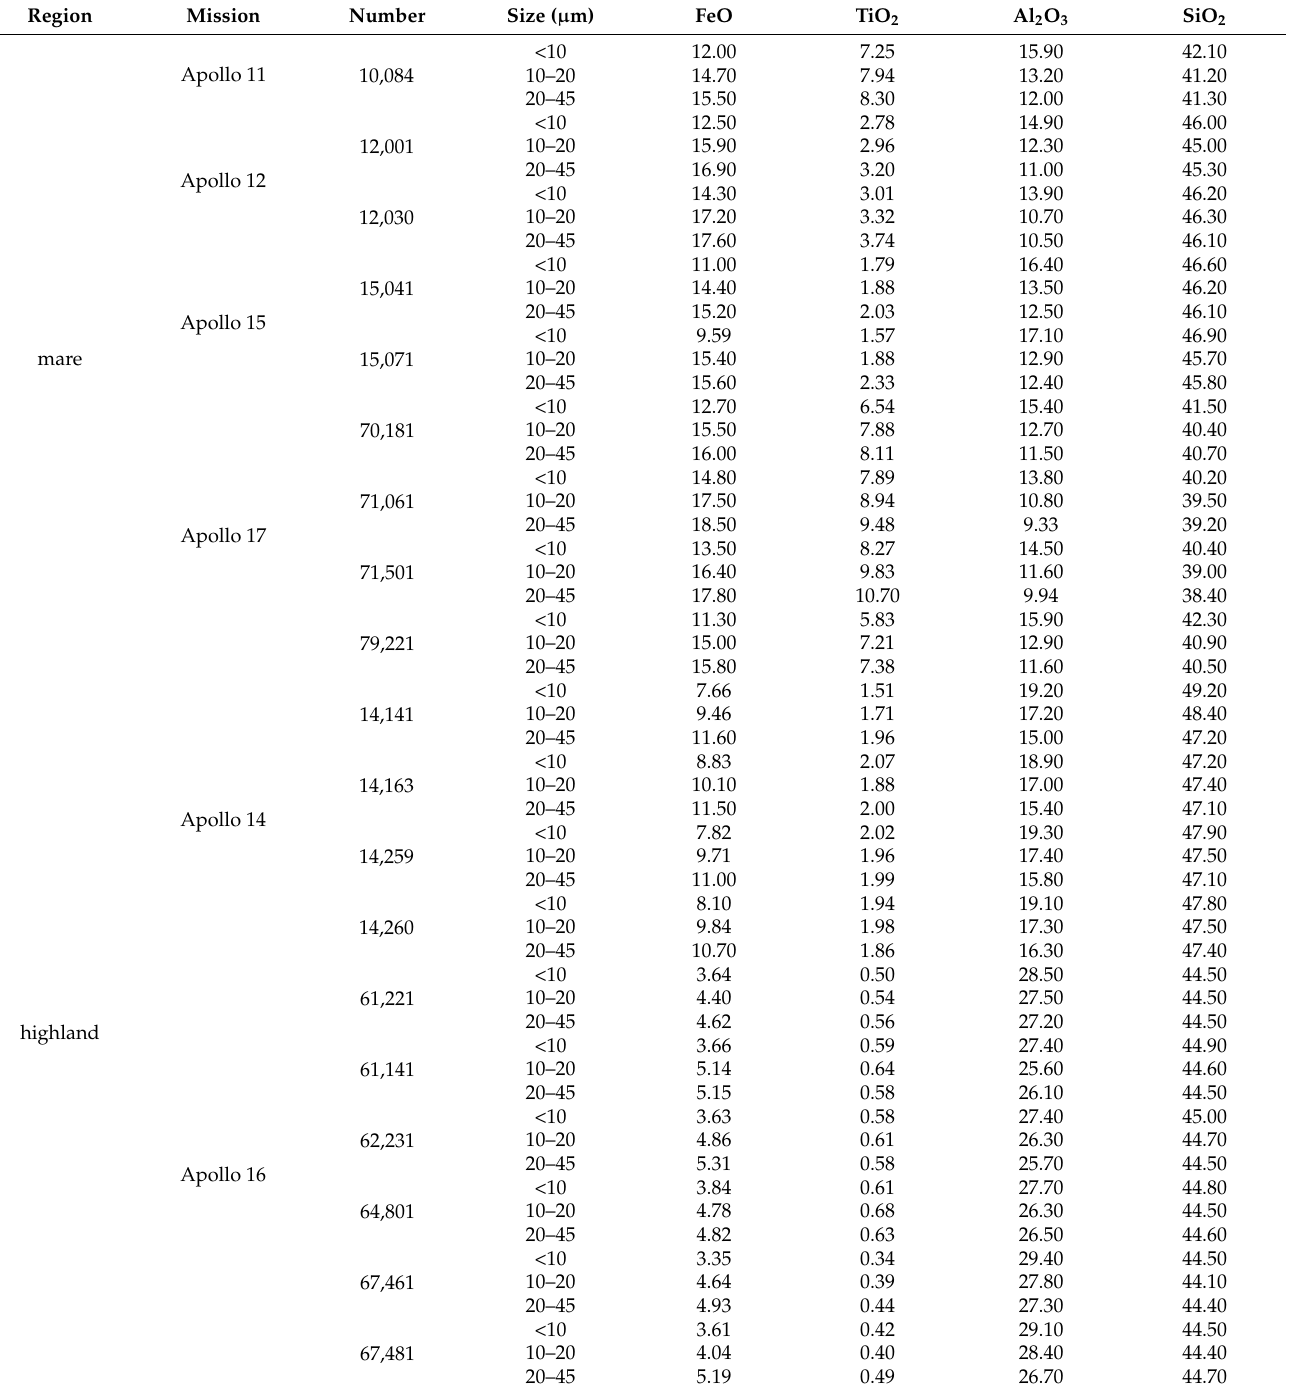
Table 1. Composition data for LSCC soils used in this paper. Region